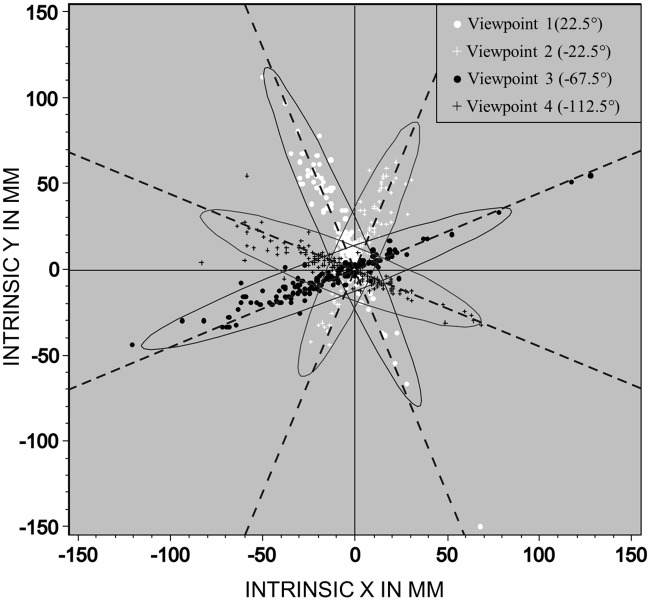
Raw distributions of errors in target location judgments.Distribution of individual location judgments from four different viewpoints. Coordinates are centered on the true target position so that deviations from 0, 0 reflect location error on the cuboid’s intrinsic spatial dimensions. The units are in millimeters. Ellipses are based on bivariate normal fits, where the perimeter of an ellipsoid corresponds to the 99% confidence curve. Participants’ variability was much higher on the egocentric front-back (major axes of the ellipses) dimension than on the left-right dimension (minor axes of the ellipses), as indicated by the elongation of the ellipses’ along the virtual lines of sight from the four different viewpoints (dashed lines).